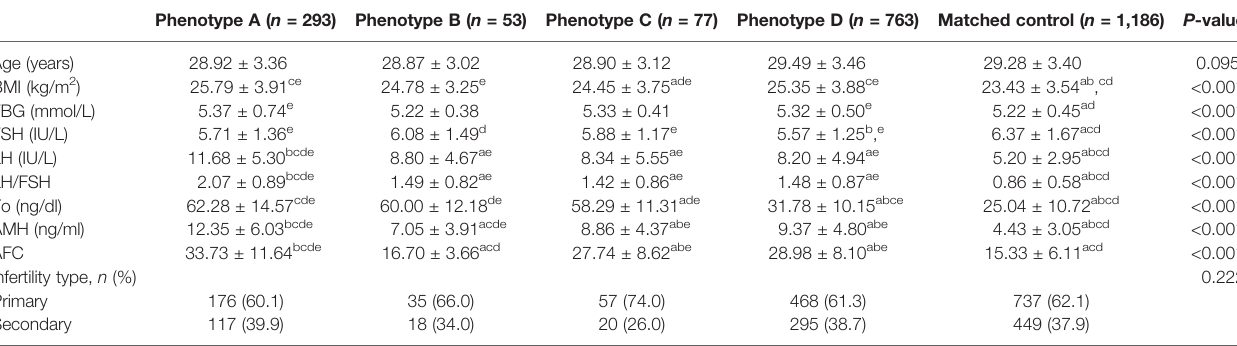
BMI, body mass index; FBG, fasting blood glucose; FSH, follicle-stimulating hormone; To, total testosterone concentration; AMH, anti-Müllerian hormone; AFC, antral follicle count. a Signi fi cantly different from phenotype